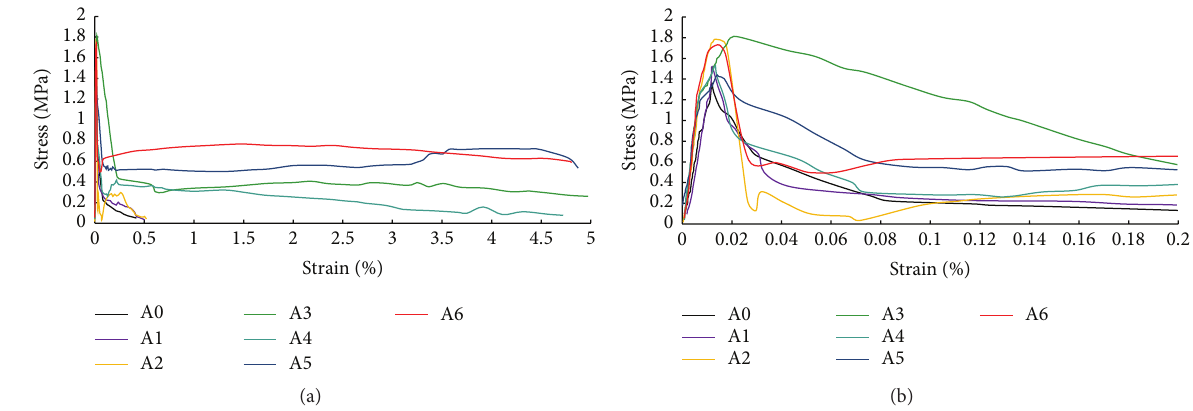
Figure 2: The axial tensile stress-strain curve of multiscale polypropylene fiber